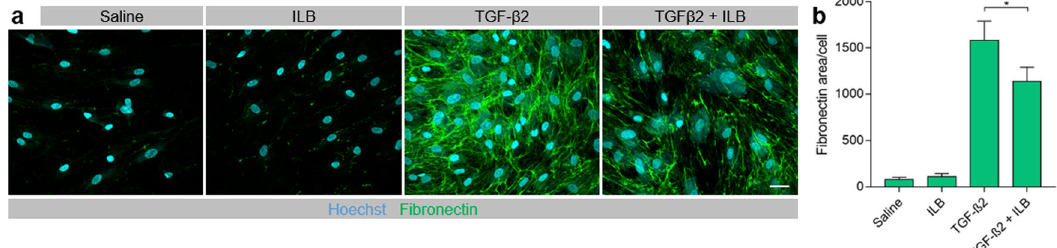
Fig. 3 ILB ® modulation of the molecular pathways involved in fi brosis. Human trabecular meshwork cells were stimulated with TGF β 2 (1.0 ng/ml) in the absence (saline) or presence of ILB ® (4.0 µM) for 72 h followed by immuno fl uorescence labelling of fi bronectin (green) and nuclei staining with Hoechst (cyan). ( a ) Representative images are maximum intensity projections from confocal Z-stacks (scale bar = 40 µm) and ( b ) the histogram shows quanti fi cation of the fi bronectin staining normalised to the number of cells (mean ± SEM, n = 6), P < 0.05 (Wilcoxon